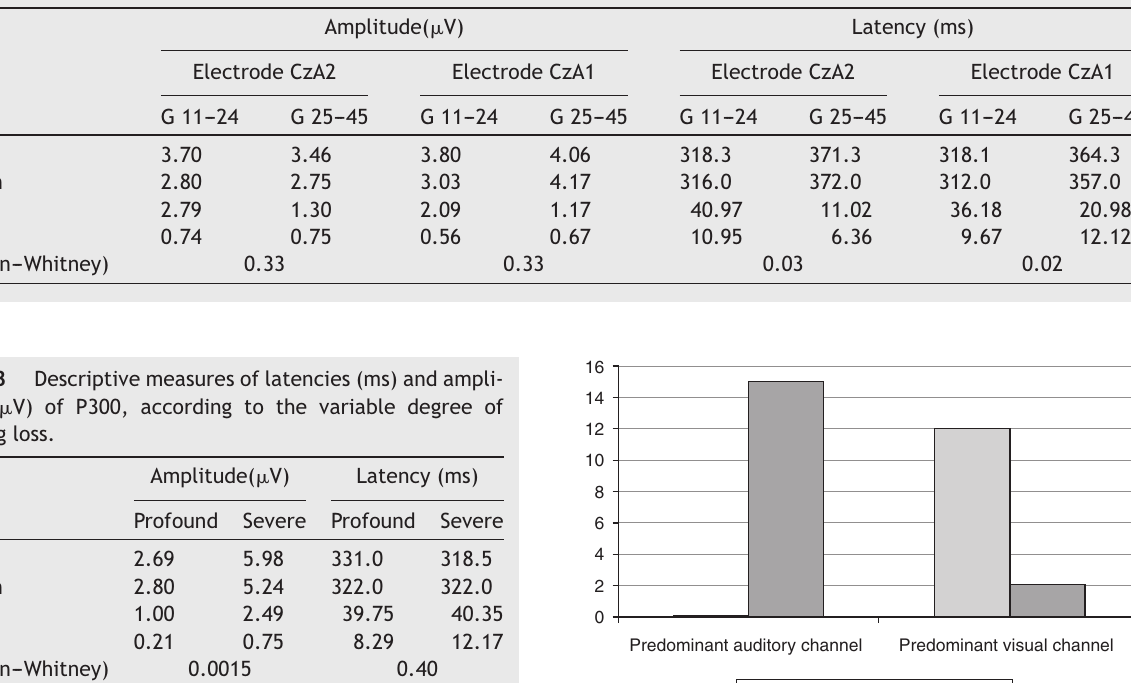
Amplitude values ( (cid:2) V) and latency (ms) for the P300 component considering two groups according to the age range (11---24 years and 25---45 years).